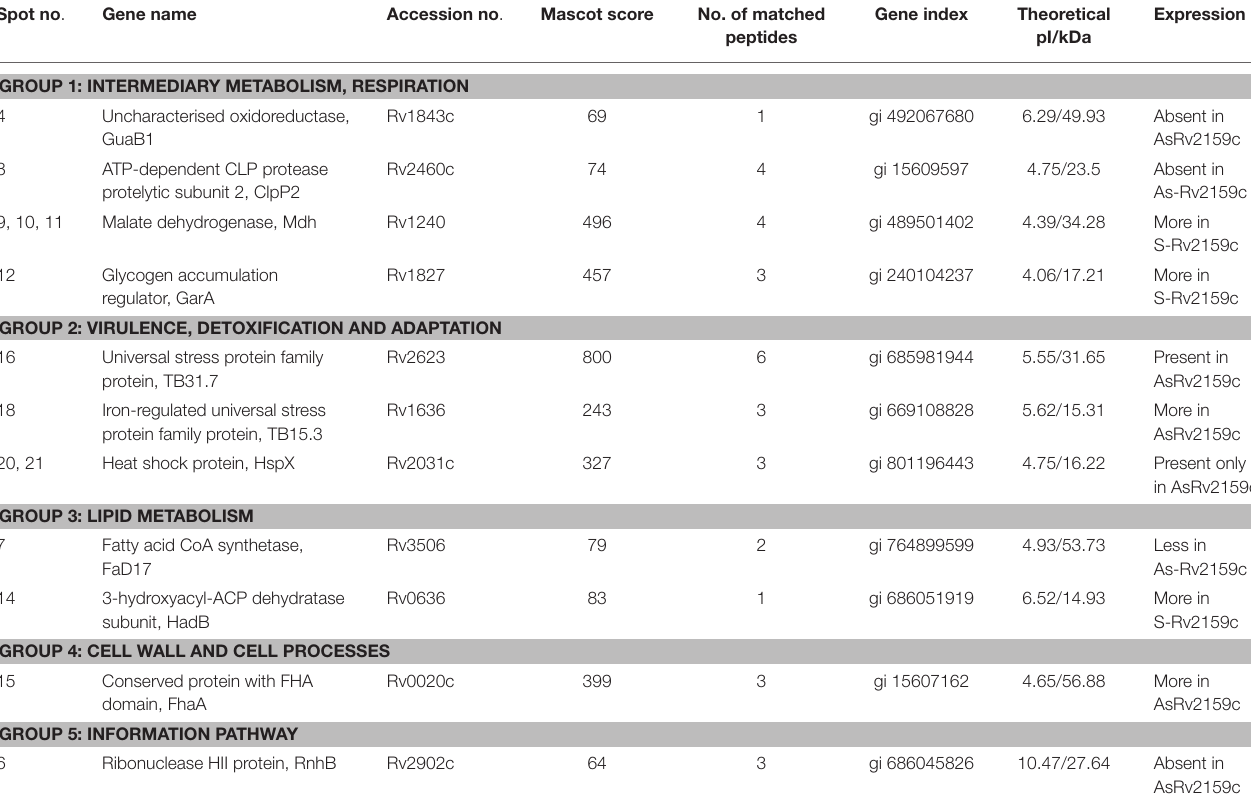
TABLE 1 | Identification of the differentially regulated 2D protein spots of Rv, S-Rv2159c, and As-Rv2159c. Spot no